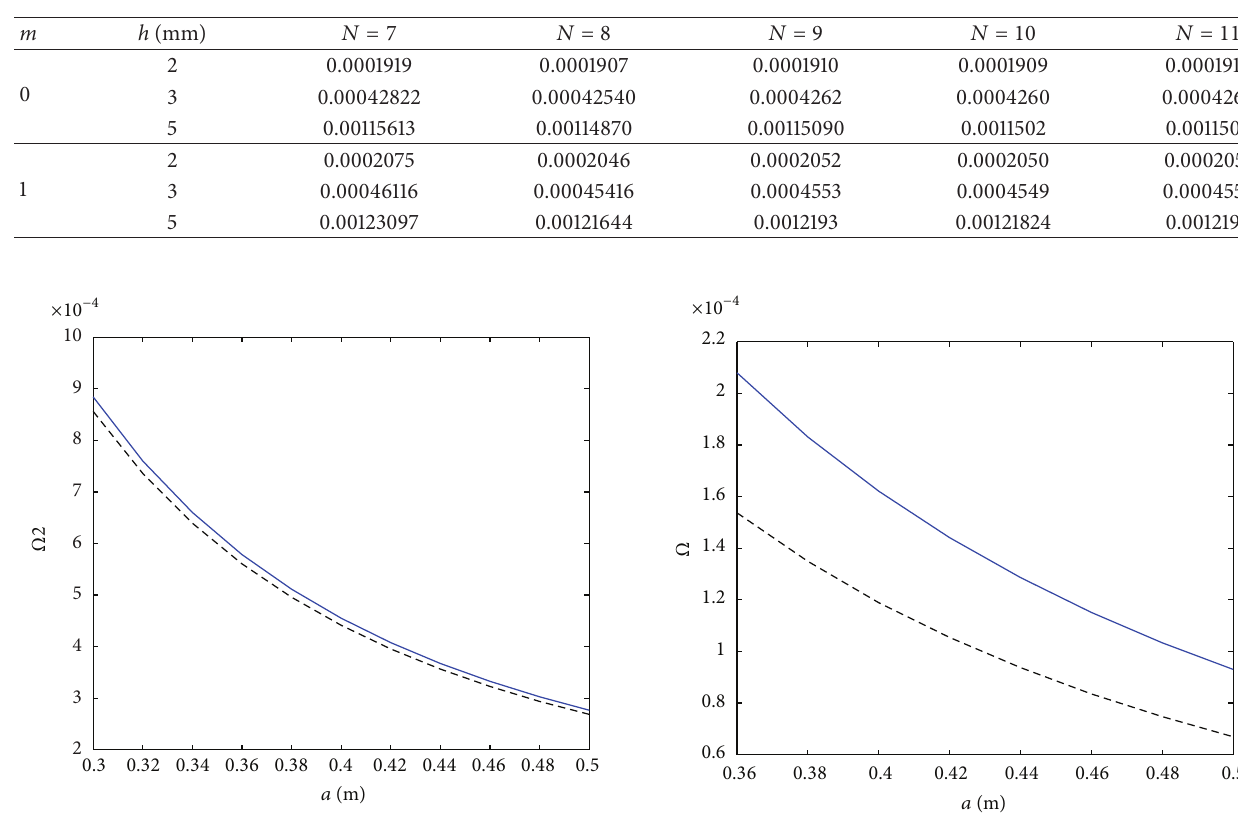
Table 3: A convergence study for the nondimensional natural frequencies associated with the first and second vibration modes of a clamped- clamped annular plate ( 𝑎 = 40 cm and 𝑏 = 5 cm).